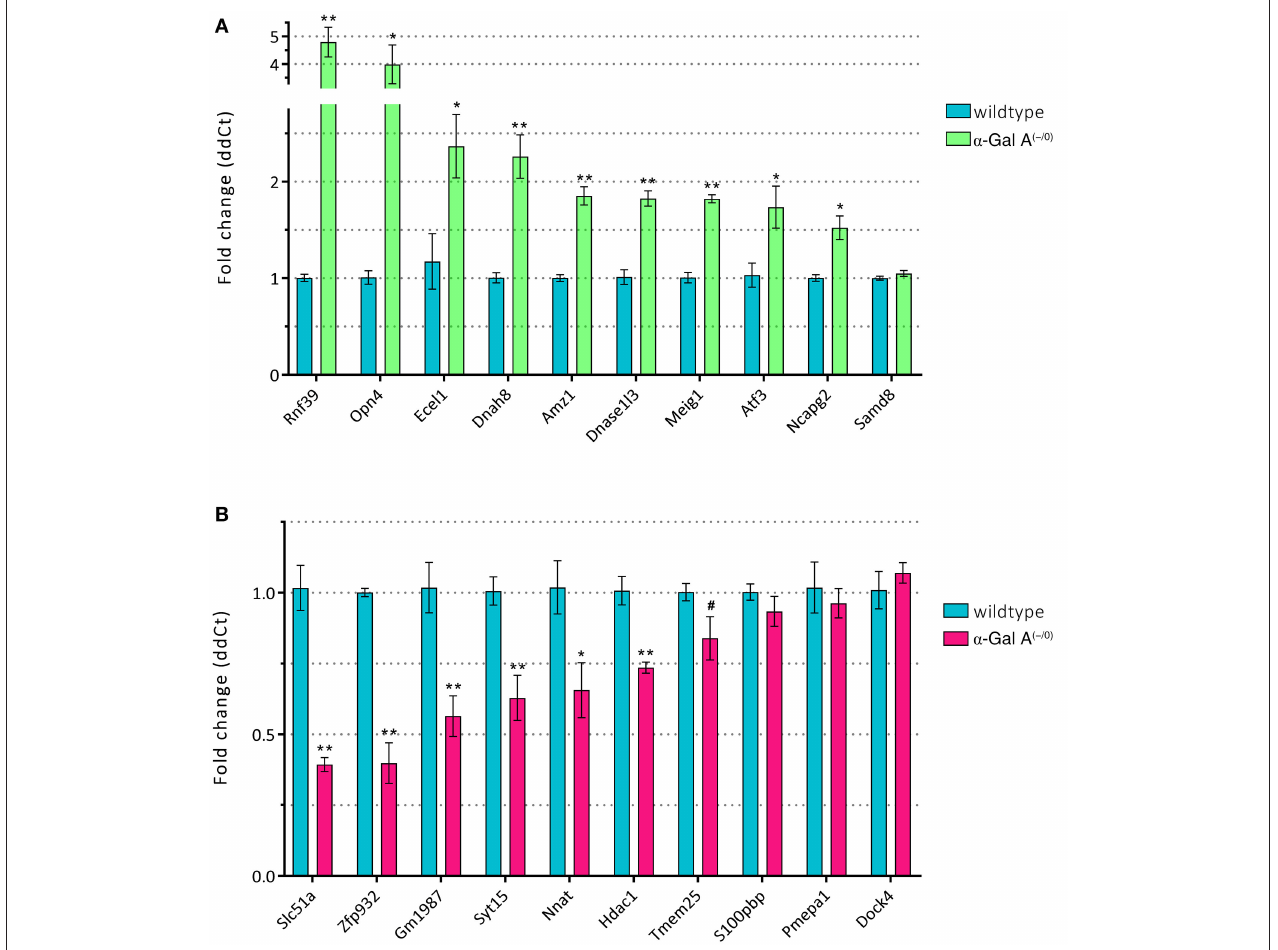
FIGURE 5 | RT-qPCR validation of up- (A) and downregulated genes (B) . * p < 0.05, ** p < 0.01, # p < 0.1.